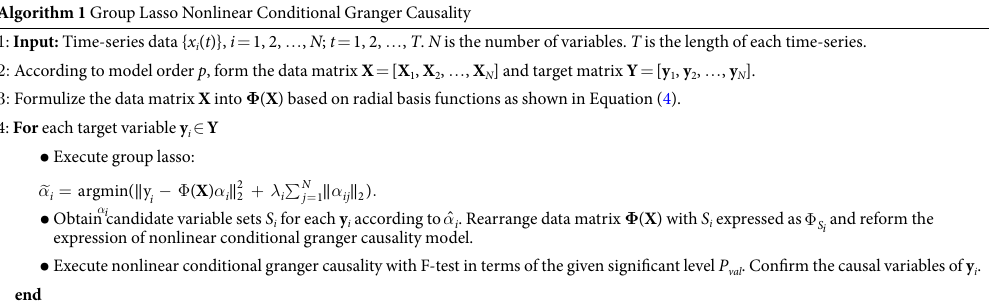
Algorithm 1 Group Lasso Nonlinear Conditional Granger